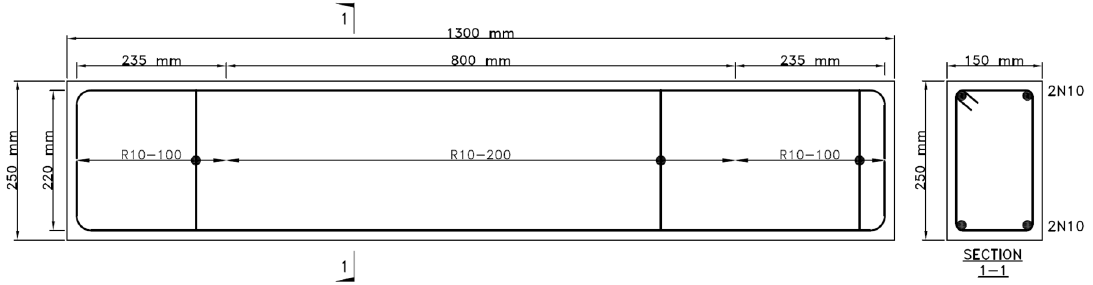
Figure 2. Details of torsion beam reinforcement. The measurements are shown in millimetres. R10-200 indicates Type R bars with 10 mm diameter at 200 mm spacing.